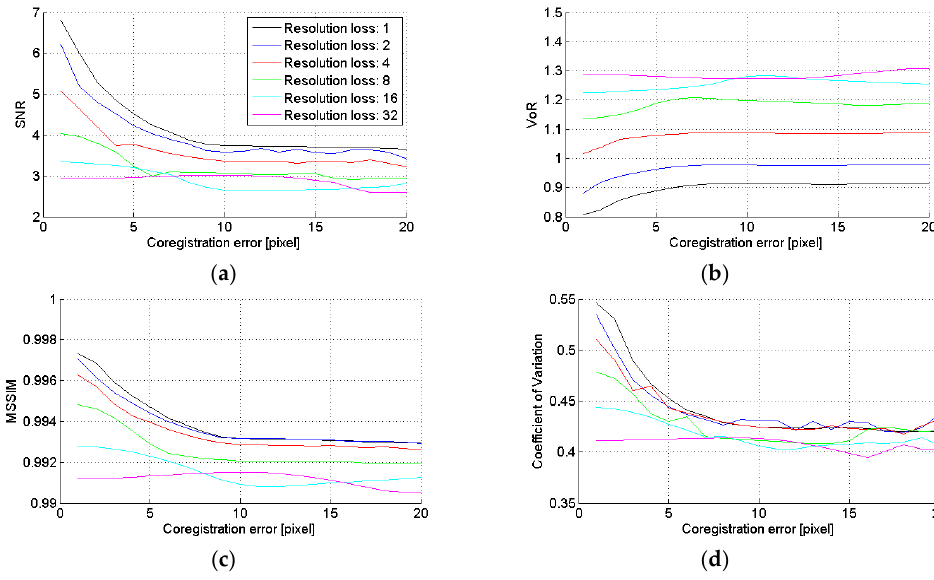
Figure 12. Sensitivity of SB-SARBM3D against coregistration errors (in pixels) between the local incidence angle map and the SAR image for different DEM resolutions. ( a ) SNR; ( b ) VoR; ( c ) MSSIM; ( d ) coefficient of variation. All of the figures share the same legend. Low-resolution DEMs provide smooth a priori scattering information. Consequently, the lower the DEM resolution, the stronger the sensitivity of SB-SARBM3D against coregistration displacements.